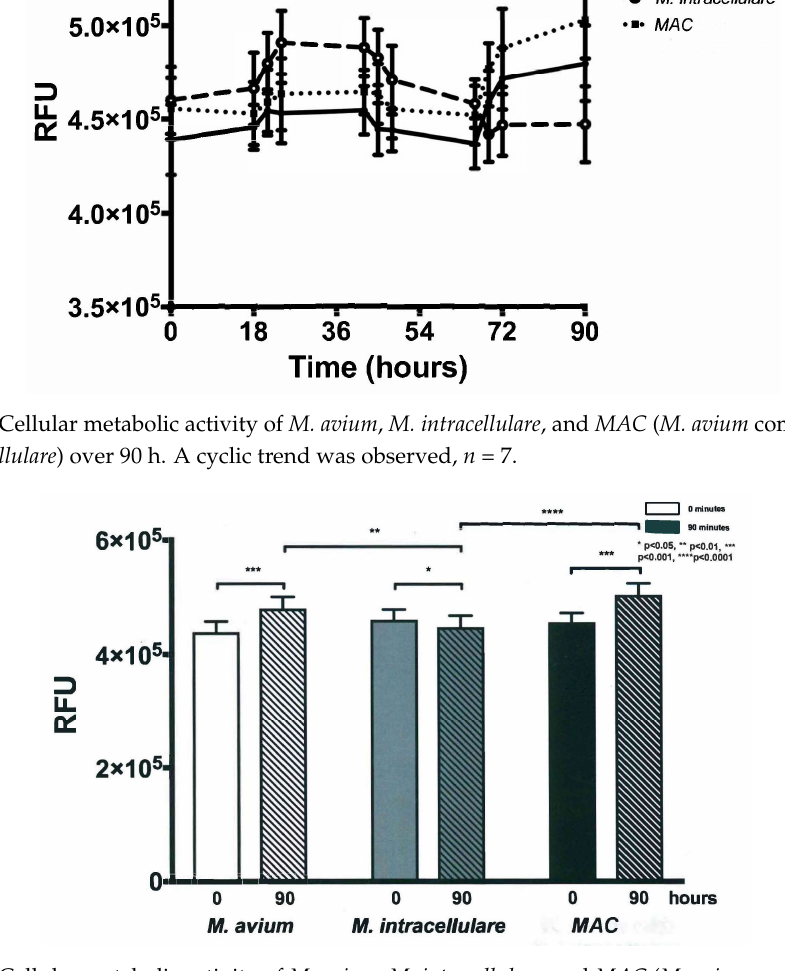
Figure 6. Cellular metabolic activity of M. avium , M. intracellulare , and MAC ( M. avium combined with M. intracellulare ) at time zero and 90 h. Increased activity after 90 h was significant for M. avium at *** p < 0.001, M. intracellulare at * p < 0.05, and MAC ( M. avium with M. intracellulare ) at *** p < 0.001 according to two-tailed, paired T -test analysis. Significant differences after 90 h were observed between M. avium and M. intracellulare at ** p < 0.01 and between M. intracellulare and MAC ( M. avium with M. intracellulare ) at **** p < 0.0001, n = 7.